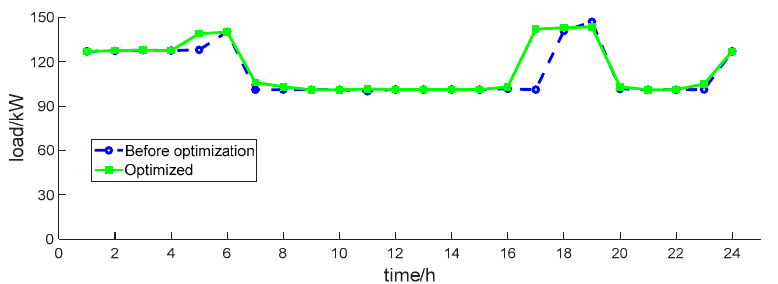
Figure 11. Electric water heater (corrected BC7) trading chain setting power.